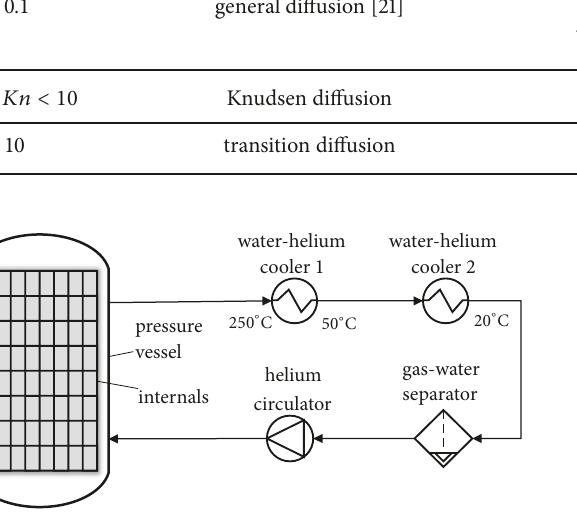
Figure 1: Dehumidification system of